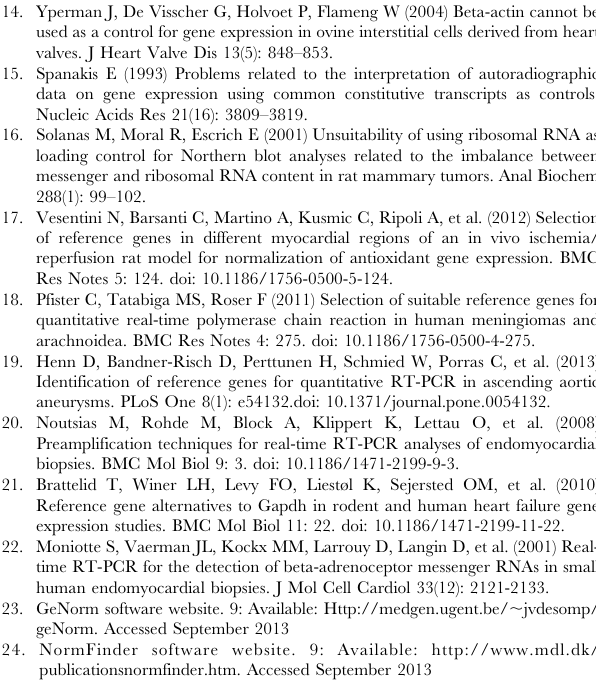
corresponding to ribosomal 28S rRNA and 18S rRNA are observed. Table S1 Weight of the tissue (Weight; mg), total RNA extracted (TRNA; ng), RNA input for reverse transcrip- tion (IRNA; ng), and Ct values of the reference genes for all the samples analyzed.